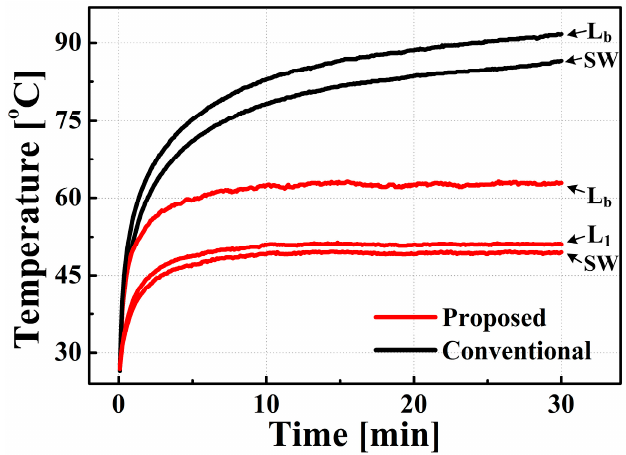
Figure 12. Temperature of switch and inductors versus operation time for the experimental converters, measured at V IN = 5 V, V O = 40 V, I O = 150 mA, and f S = 1 MHz.